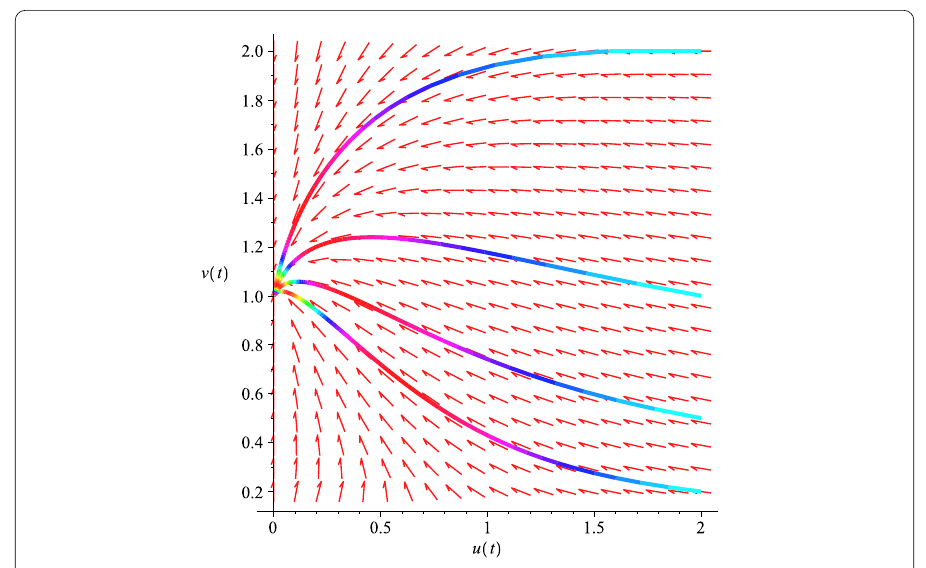
Figure 1 Dynamic behaviors of the system (5.1), the initial condition ( u (0), v (0)) = (2,2),(2,1),(2,0.2) and (2,0.5),